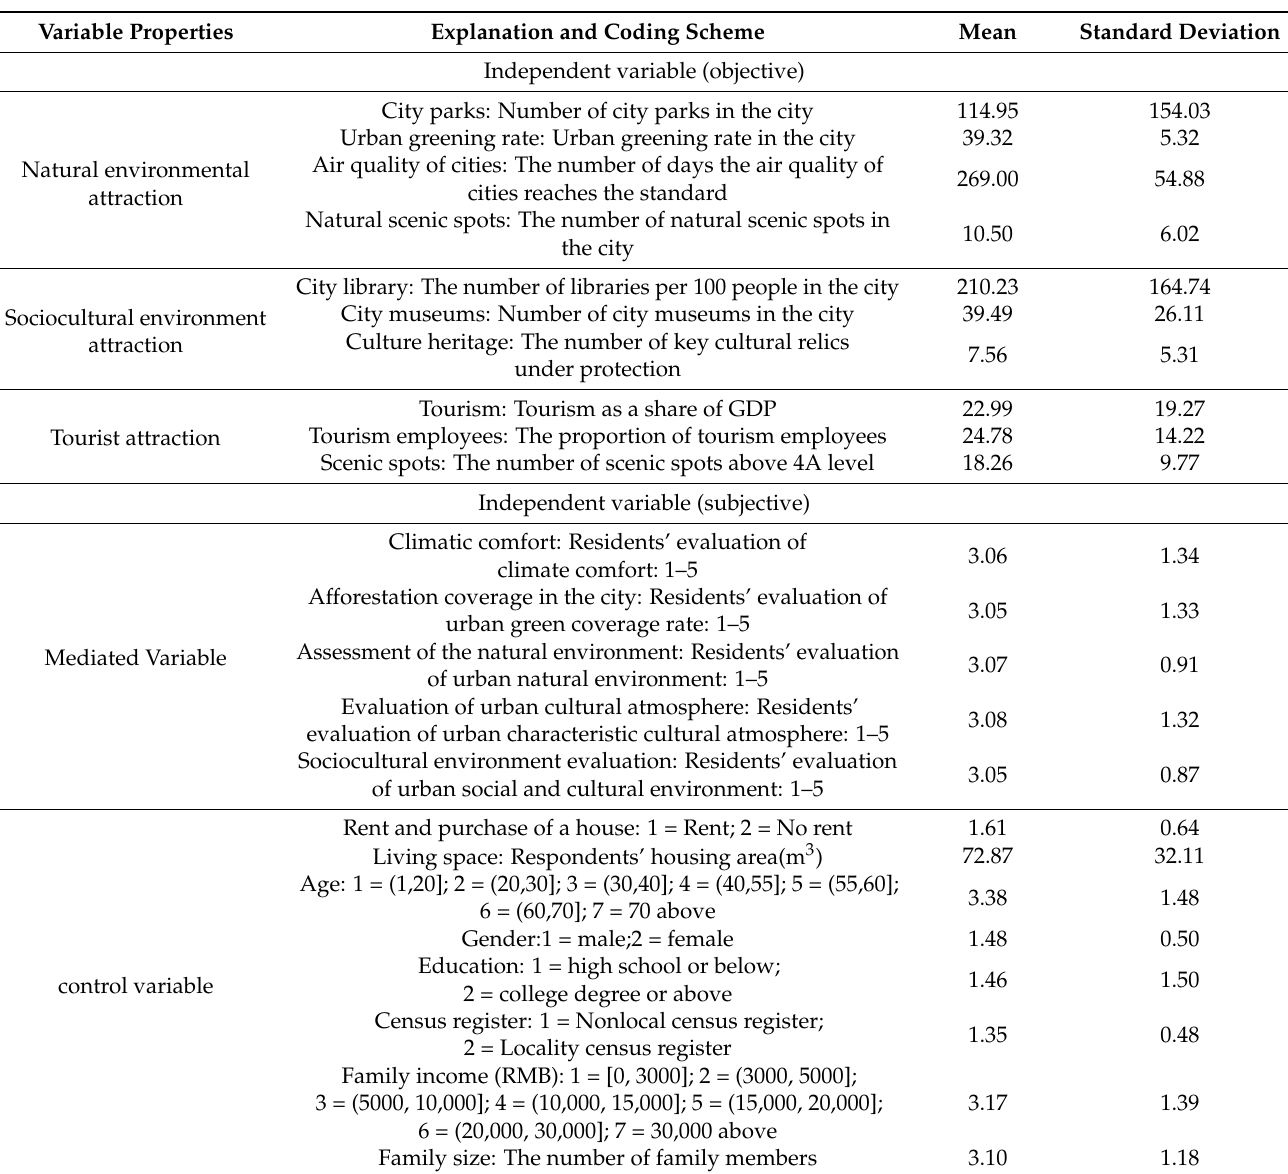
Table 1. Descriptive statistics of